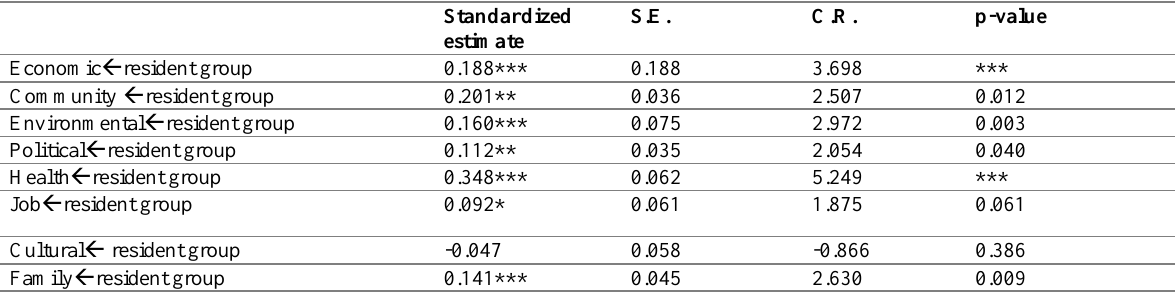
Table 5: Impact of type of resident group on each latent variable (each well-being